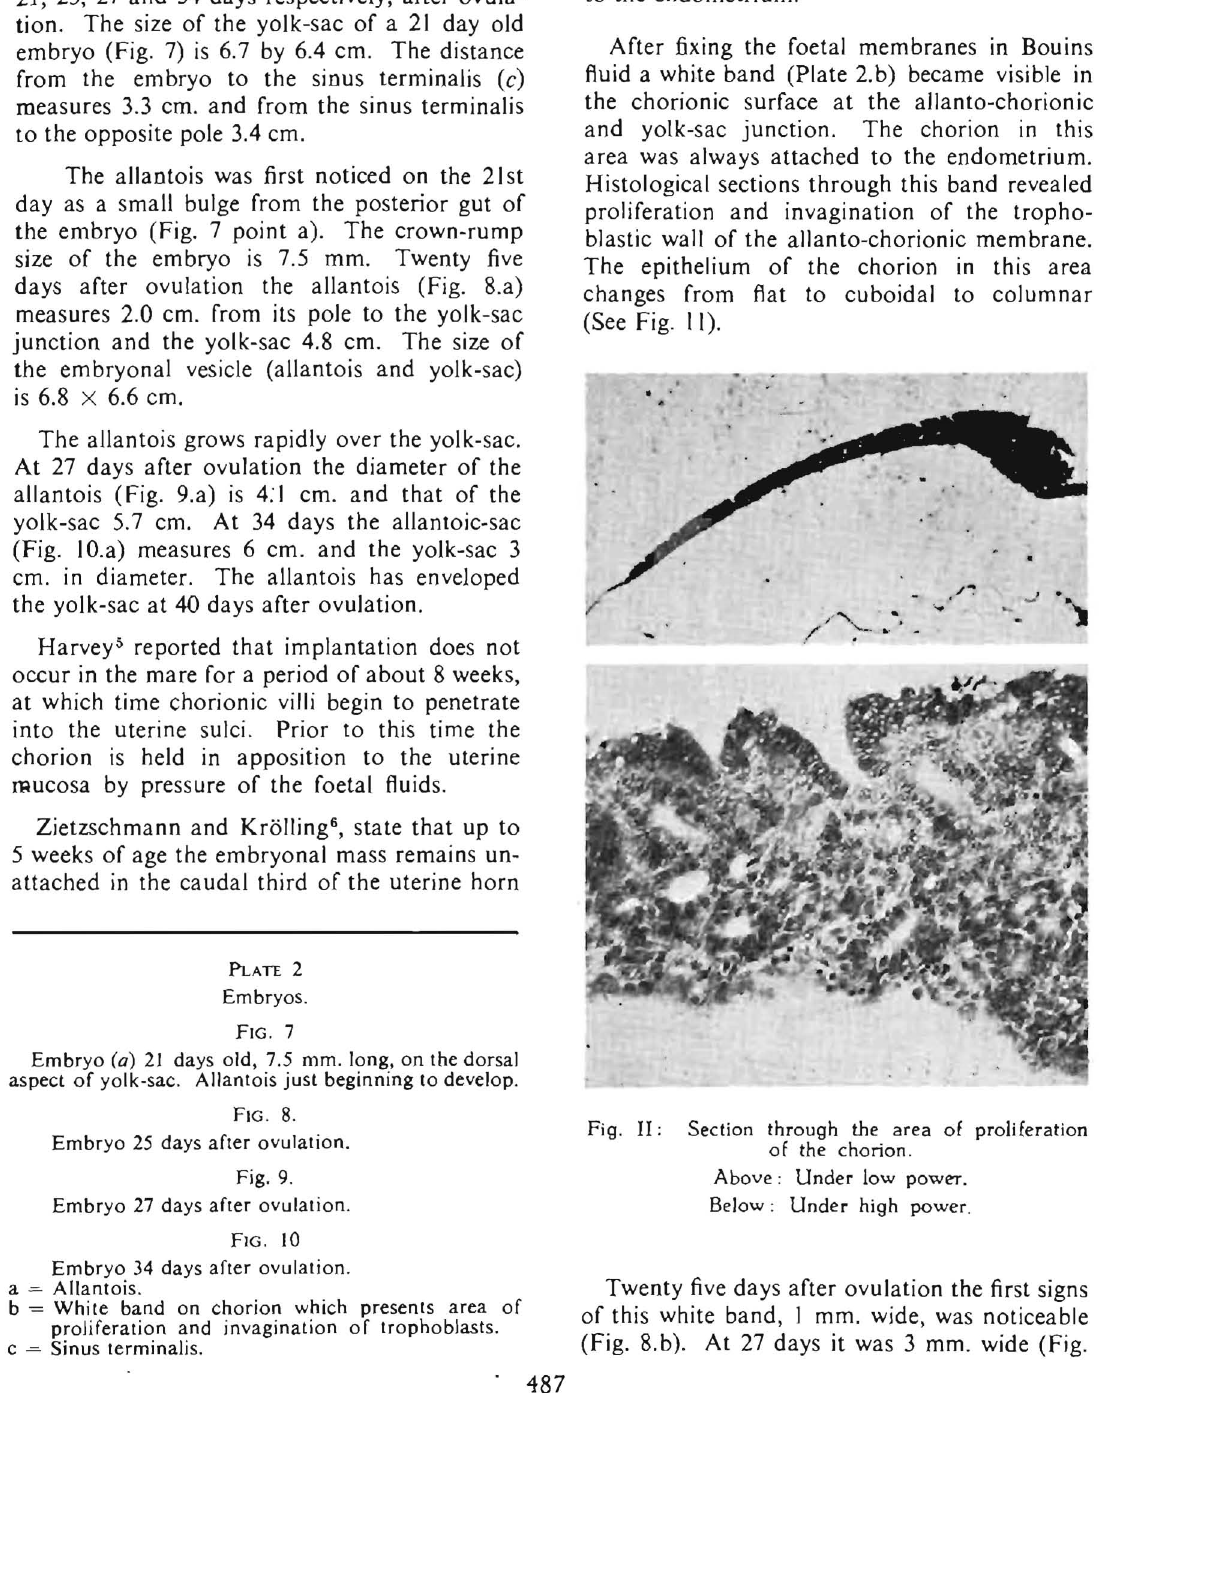
Plate 2: Figs. 7 to 10 show embryos, within their foetal membranes, of mares slaughtered 21, 25, 27 and 34 days respectively, after ovula tion. The size of the yolk-sac of a 21 day old embryo (Fig. 7) is 6.7 by 6.4 cm. The distance from the embryo to the sinus terminalis (c) measures 3.3 cm. and from the sinus terminalis to the opposite pole 3.4 cm.